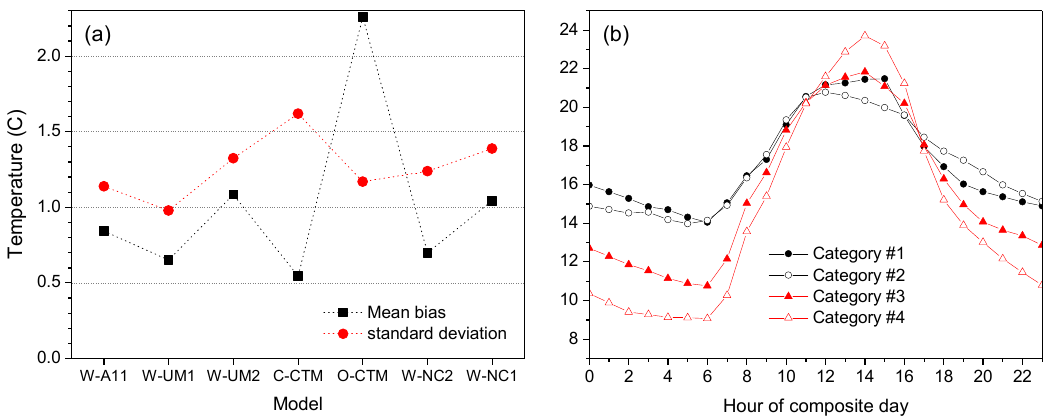
Figure 3. ( a ) Mean bias, and its standard deviation, of hourly observed and simulated 2 m temperature, and ( b ) diurnal composite observed 2 m temperature at Westmead for days in each of the radon-based atmospheric mixing categories (Table 1).